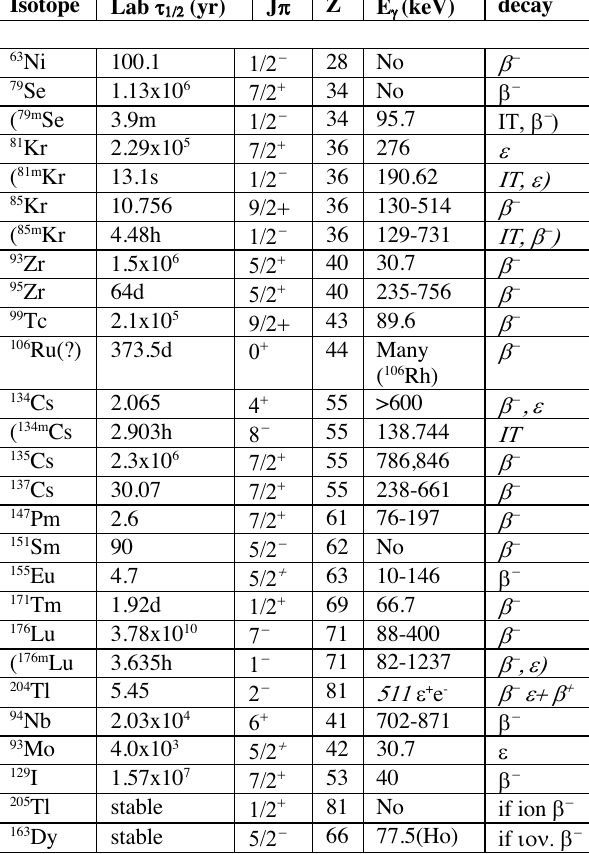
Table 1. Preliminary list of potential physics cases of astrophysical